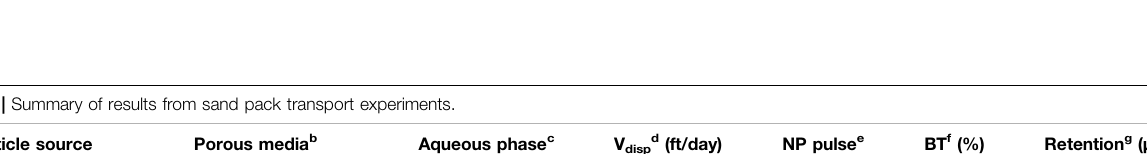
FIGURE 7 | Ef fl uent breakthrough curves from column chromatography sand pack experiments showing the difference in the transport and mass recovery between Dex-SPIONs in DI water and in various ionic solutions, i.e. API brine and calcium chloride (CaCl 2 ) / sodium chloride (NaCl) solution.